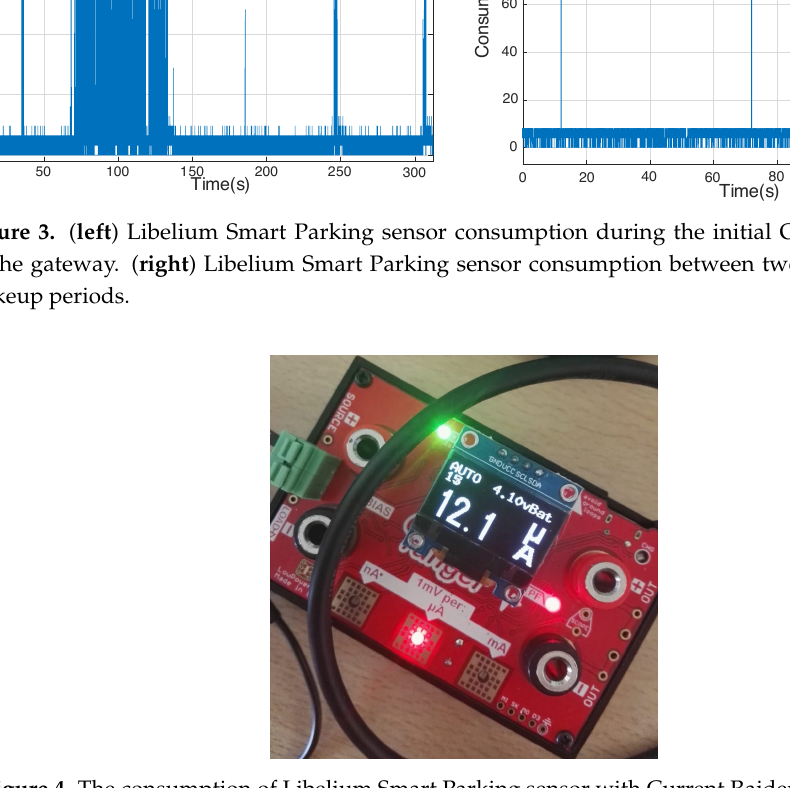
Figure 4. The consumption of Libelium Smart Parking sensor with Current Raider in sleep